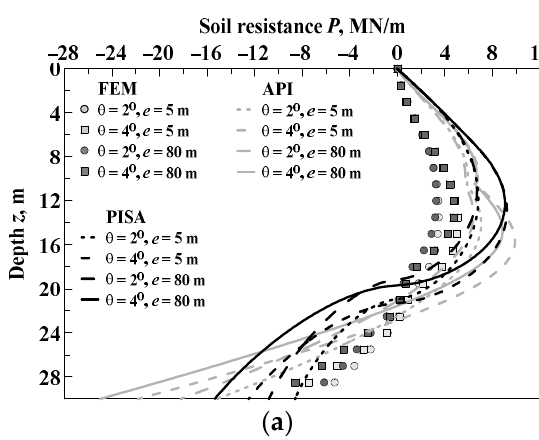
Figure 9. Soil resistance profiles under typical rotations and loading eccentricity in 65% relative density sand: ( a ) D = 4 m, ( b ) D = 10 m.